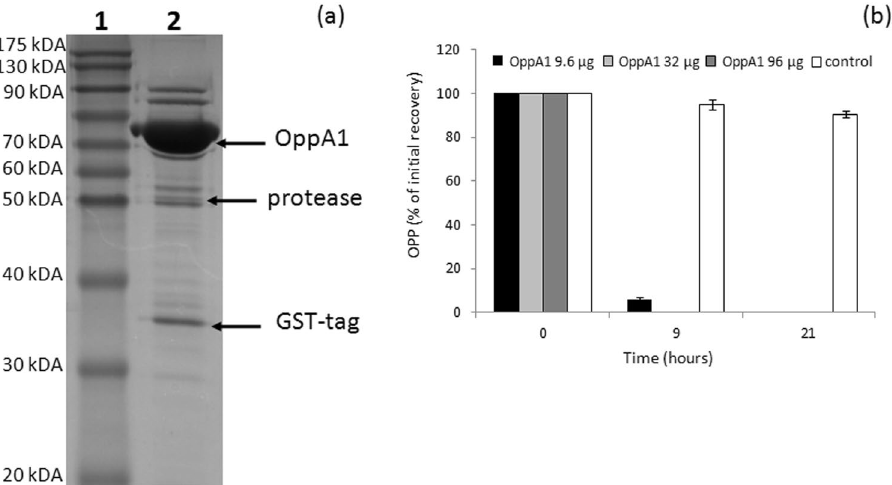
Figure 5. SDS-PAGE analysis of the flavin-dependent monoxygenase of ortho -phenylphenol (OppA1) isolated by Sphingomonas haloaromaticamans strain P3. Lane 1: Molecular mass ladder; Lane 2: Elution from a Protino Glutathione Agarose 4B column, and after in column digestion with protease, where the bands of OppA1, protease and GST-tag are indicated with arrows; ( b ) OPP degradation by different starting amounts of the purified OppA1. Each value is the mean of three replicates ± the standard